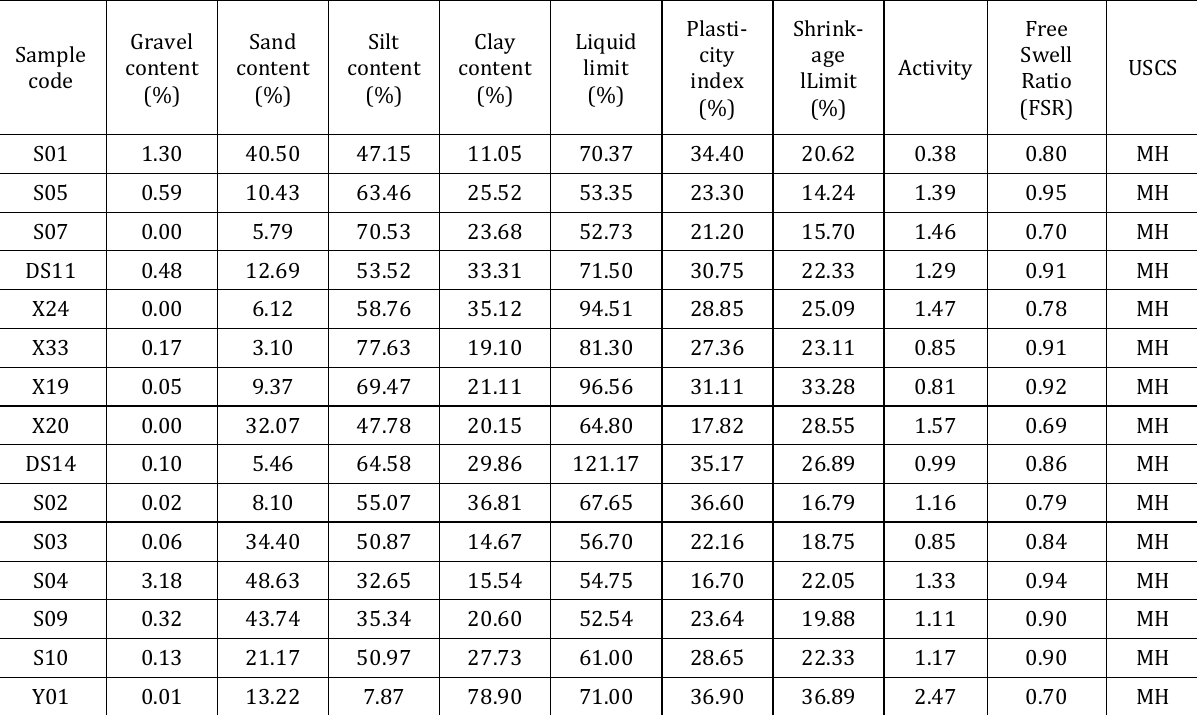
Table 2. Physical properties of the soil samples in this study